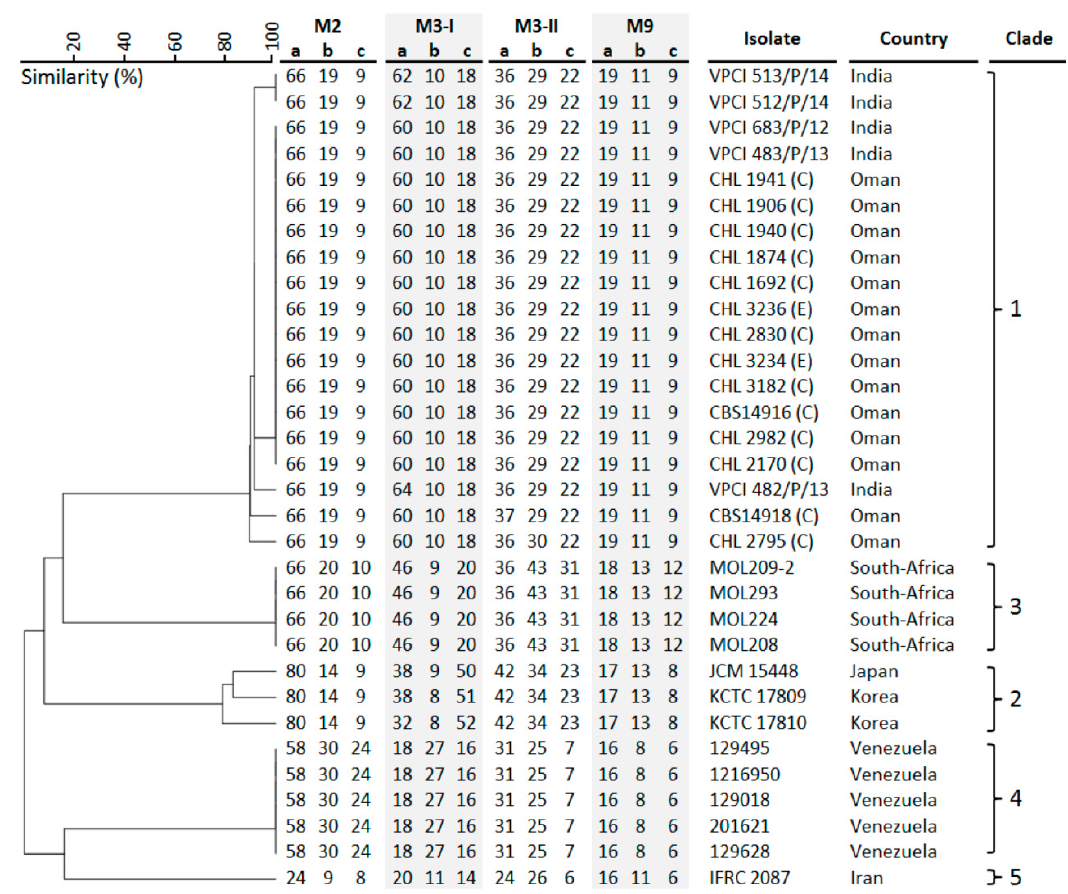
Figure 4. Small tandem repeat (STR) analysis of 12 STR C. auris targets with a repeat size of 2, 3, or 9 nucleotides. The isolates from Oman clustered with Indian isolates in the South Asian clade 1, while isolates from South Africa, Japan / Korea, Venezuela and Iran each clustered in the other 4 major C. auris clades. E = environmental; C = clinical.